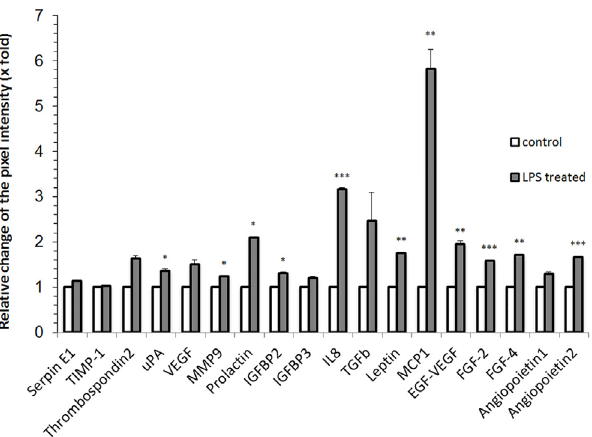
Fig 3. Release of proangiogenic factors by LPS-stimulated SDSC. After 24 hours of cultivation conditioned media were collected (n = 3) and the presence of several bioactive molecules was detected. Proangiogenic factors like IL-8, MCP-1, EGF-VEGF, FGF-2 and Angiopoietin-2 showed a significant increase. Furthermore, uPA, MMP-9, Prolactin, IGFBP-2, Leptin and FGF-4 were significantly elevated. A positive tendency was obvious in Thrombospondin-2, VEGF, TGFb and